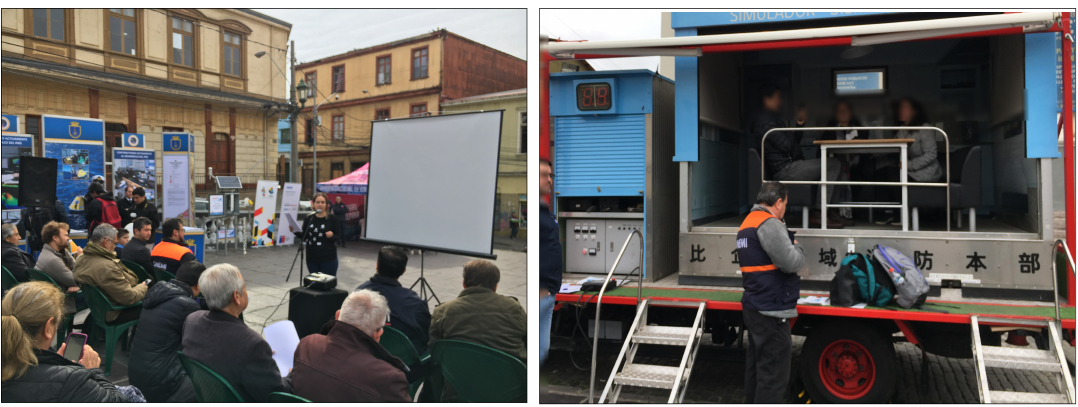
Figure 3. Setup at La Matriz square and the earthquake simulator brought by ONEMI.